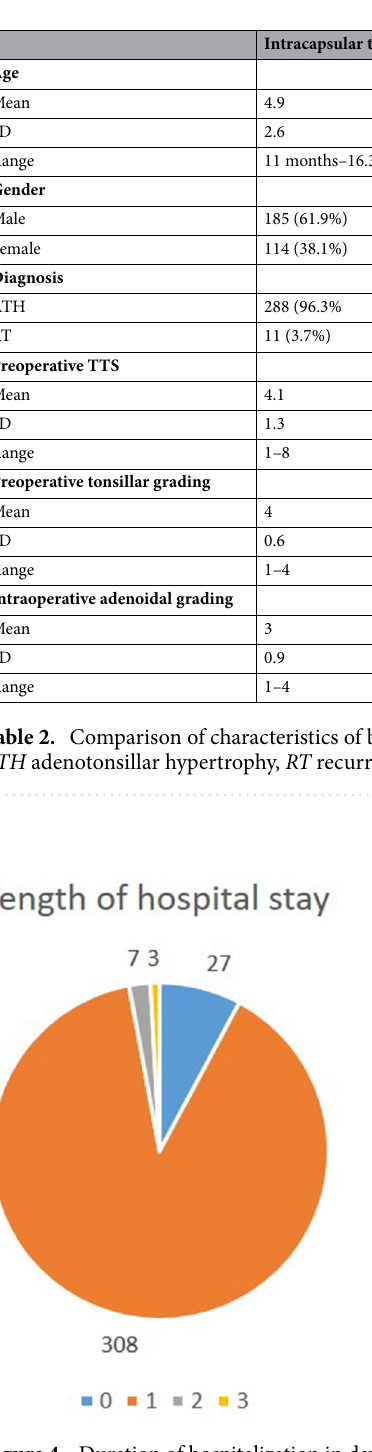
Figure 4. Duration of hospitalization in